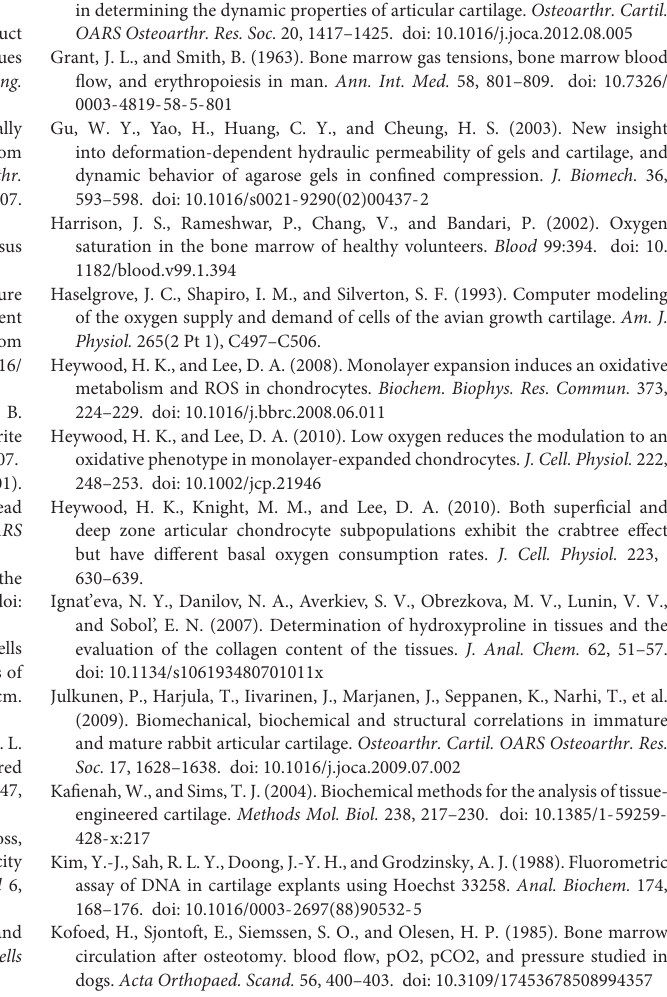
Supplementary Figure 1 | A replicate study was performed using cells from a separate set of donors and oxygen concentration in the center of each construct was measured. Supplementary Figure 2 | The percentage change in cell density in sample cores and annuli following 24 days of culture. Supplementary Figure 3 | High-magnification (20x) images of representative sections stained with Alcian Blue and Nuclear Fast Red following 24 days of culture. Supplementary Figure 4 | FEA models were analyzed to determine the percentage volume of each sample that contained nodes with O 2 values that lay within the specified oxygen ranges at day 24. Supplementary Figure 5 | Oxygen concentration as measured in the center of constructs from each study group for both the main and replicate studies